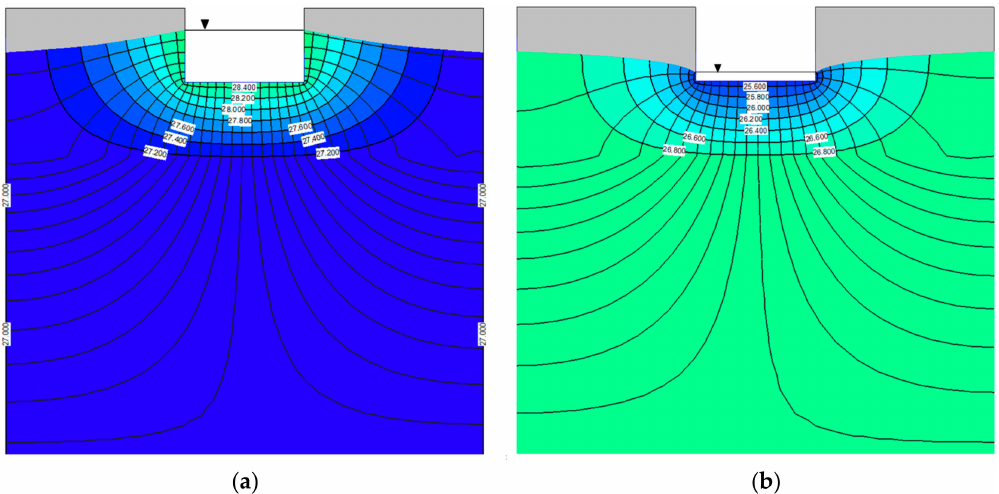
Figure 9. SEEP2D calculated free groundwater table, piezometric head contours, and flow lines for ( a ) H r = 28,5 m and Φ * = 27 m and ( b ) H r = 25,5 m and Φ * = 27 m.